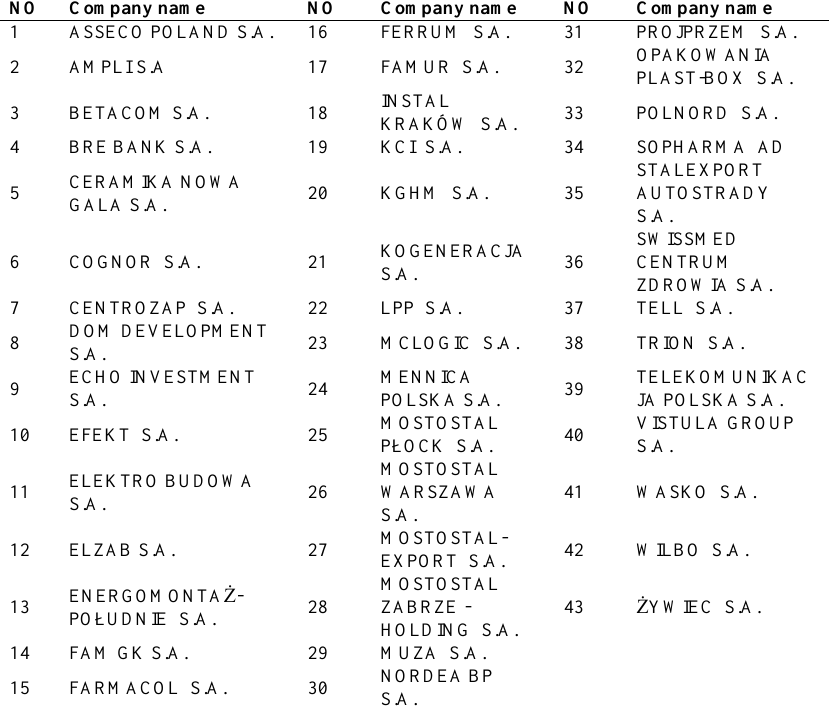
Table 1. Companies, which shares were included in the study for individual assets